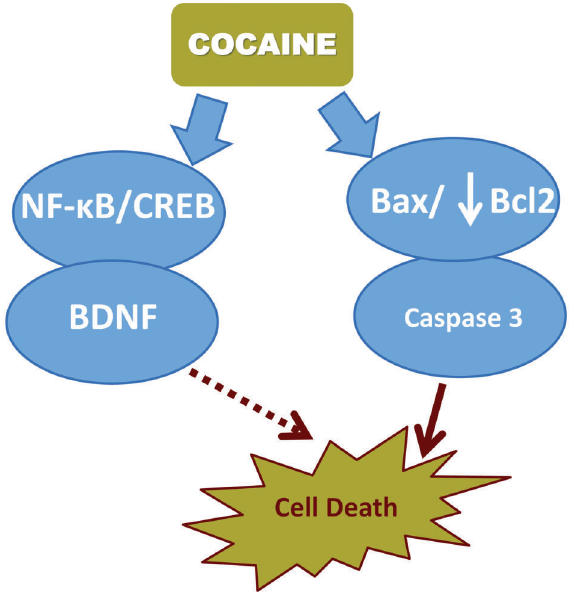
Figure 1. Schematic representation of the neurotoxic action of cocainein PC12 cells. Thetreatmentof PC12 cells with cocaine can alter the Bax/Bcl-2 ratio, reducing the Bcl2 levels, which could lead toactivationof caspase3andthetriggeringof thecelldeathprocess seen after 24 h of treatment. On the other hand, to protect the cell from cocaine toxicity, both NF- k B and CREB are activated at 6 h. The activation of these transcription factors could lead to transcrip- tion of anti-apoptotic genes, such as brain-derived neurotrophic factor (BDNF), that act to reverse the process of cell